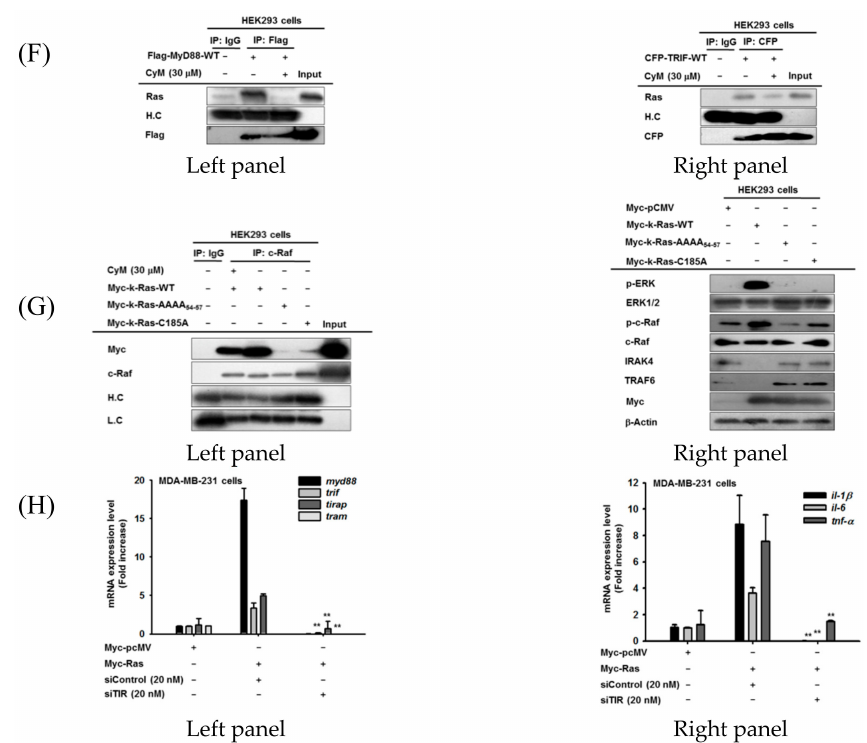
Figure 6. ICMT / Ras-mediated inflammatory responses are regulated by the TIR domain of MyD88 and TRIF.(( A , C ),leftpanel)AP-1-mediatedluciferaseactivitywasanalyzedbyreportergeneassayinHEK293 cells transfected with MyD88 and its mutant constructs [ MyD88 ( Y58F ), MyD88 ( ∆ ITAM ), MyD88 ( ∆ DD ), MyD88 ( ∆ ID ), and MyD88 ( ∆ TIR )] ( A ) and in HEK293 cells transfected with TRIF and its mutant construct CFP-TRIF- ∆ TIR (( C ), left panel). Luminescence levels were determined with a luminometer. (( B , C ), right panel) Total and phospho-protein levels of MAPKs (ERK1 / 2, JNK1 / 2, and p38) in HEK293 cells transfected with MyD88 and its mutant constructs [ MyD88 ( Y58F ), MyD88 ( ∆ ITAM ), MyD88 ( ∆ DD ), MyD88 ( ∆ ID ),and MyD88 ( ∆ TIR )]( B )andinHEK293cellstransfectedwith TRIF anditsmutantconstruct CFP-TRIF- ∆ TIR (( C ), right panel). (( D – G ), left panel) Binding of endogenous Ras ( D , F ) and Myc-tagged RAS and its mutants ( Myc-K-RAS-AAA 54-57 and Myc-K-RAS-C185A ) ( E ) to MyD88 (( D , E ), left panel), TRIF (( D , E ), right panel), and c-Raf (( G ), left panel) was evaluated using immunoprecipitation and immunoblotting analyses with total lysates of HEK293 cells transfected with MyD88-WT or MyD88- ∆ TIR (( D , E ), left panel) and TRIF and TRIF- ∆ TIR (( D , E ), right panel) in the absence ( D , E ) or presence (( F , G ), left panel) of CyM (30 µ M). (( G ), right panel) Total and phospho-protein levels of ICMT, c-Raf, ERK1 / 2, IRAK4, and TRAF6 from whole lysates of HEK293 cells transfected with Myc-tagged RAS or its mutants ( Myc-K-RAS-AAA 54–57 and Myc-K-RAS-C185A ) were analyzed using immunoblotting analysis. ( H ) The mRNA expression levels of TIR-domains containing adaptor molecules (MyD88, TRIF, TIRAP, and TRAM) ( H , left panel) and inflammatory genes (IL-1 β , IL-6, and TNF- α ) (( H ), right panel) were measured using real-time PCR in MDA-MB-231 cells transfected with Ras in the presence or absence of siTIR (20 nM). **: p < 0.01 and ***: p < 0.001 compared to MyD88 or TRIF-WT-transfected